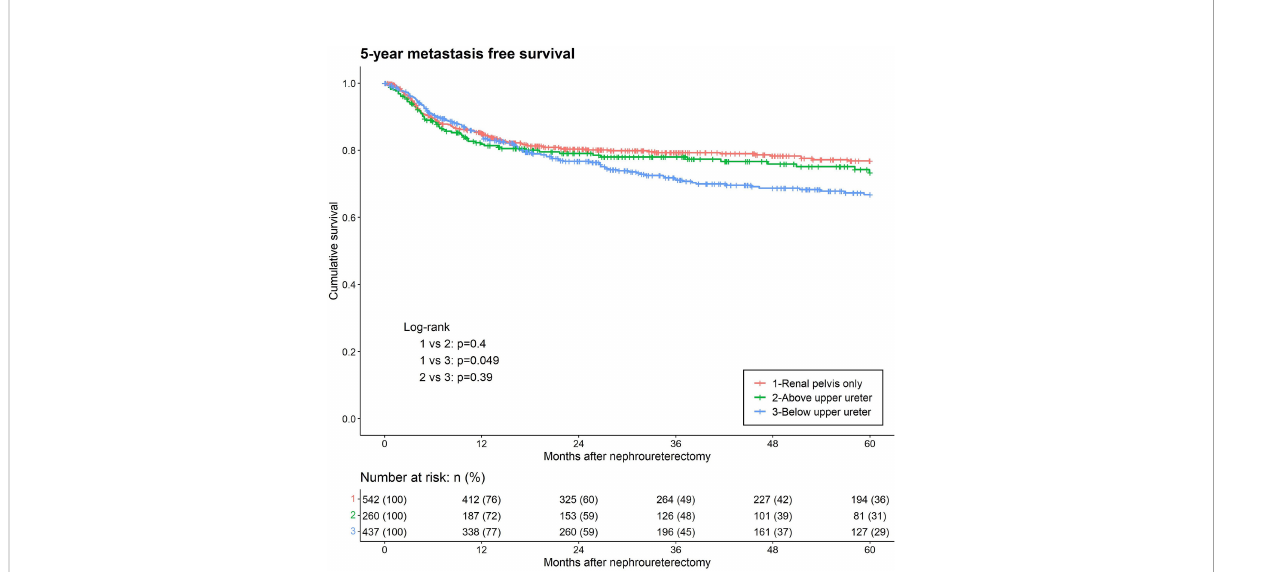
FIGURE 3 Kaplan-Meier analyses for 5-year metastasis-free survival strati fi ed by the lowest level of tumor involvement among patients with upper tract urothelial carcinoma following radical